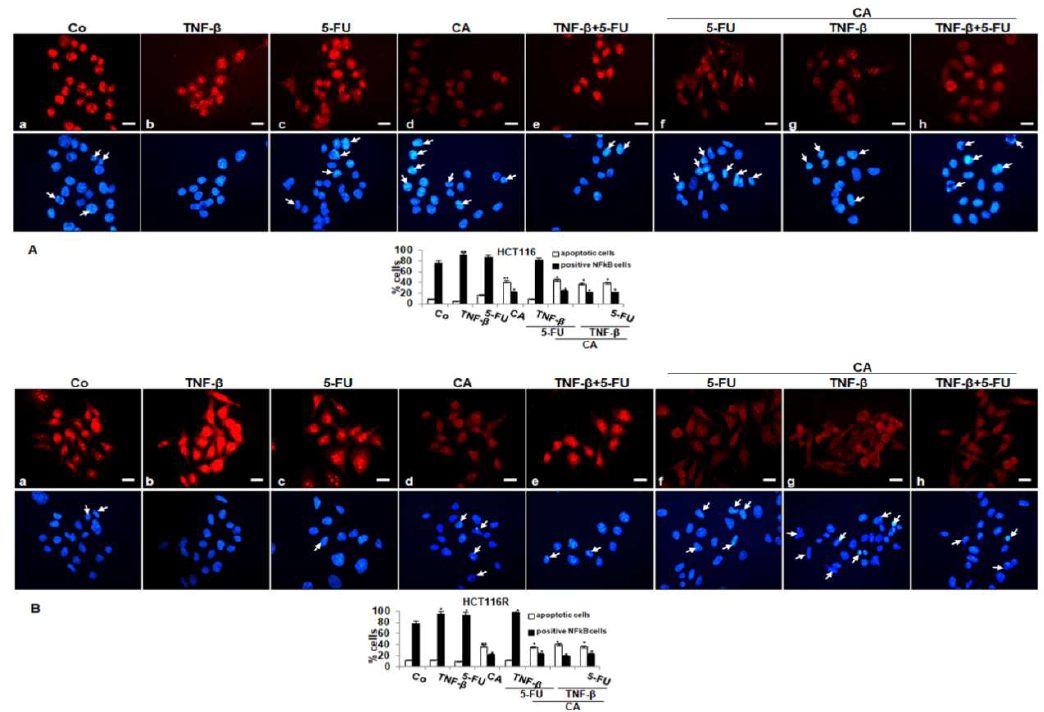
Figure 4. E ff ect of Calebin A and / or 5-FU on TNF- β -promoted activation and nuclear translocation of p65-NF κ B in CRC cells in monolayer tumor cultures. Serum-starved HCT116 ( A ) and HCT116R ( B ) cells in the monolayer culture were treated as described in the Materials and Methods section, labeled for p65 by immunofluorescence and counterstained with DAPI. All experiments were performed at least in triplicate and quantification of positively labeled p65-NF- κ B-nuclei and apoptotic nuclei (white arrows) were performed by counting 500–800 cells from 20 di ff erent microscopic fields. Values were compared with the control. p < 0.05 (*) and p < 0.01 (**) were considered statistically significant. Magnification 400 × ; scale bar = 30